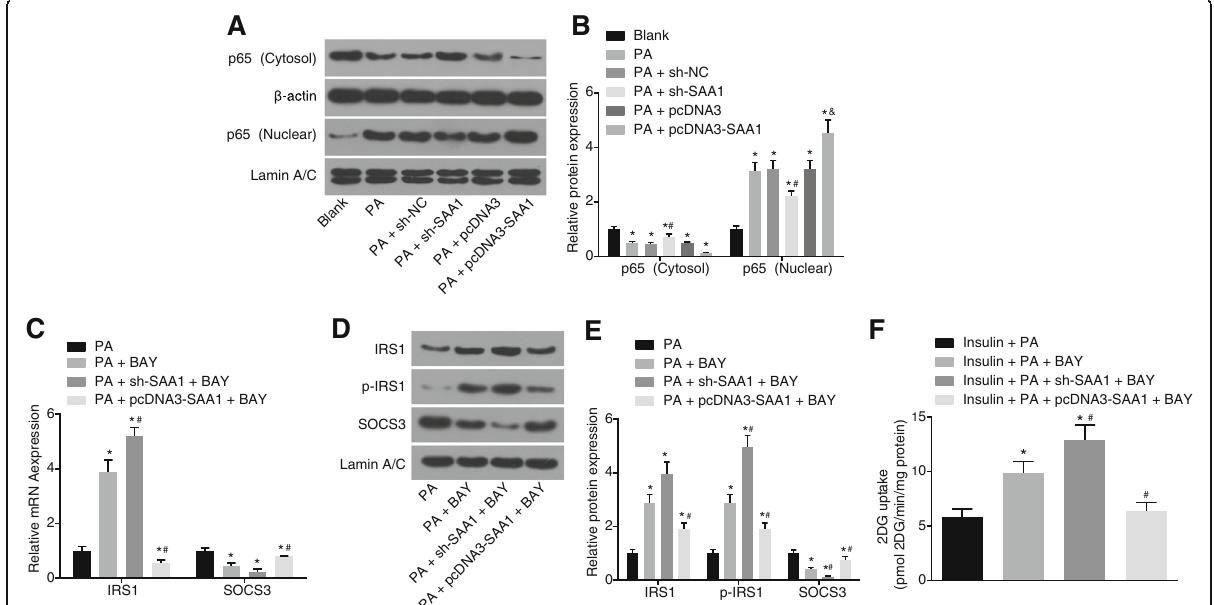
Fig. 3 Silencing of SAA1 exerts an inhibitory effect over PA-induced insulin resistance via the activation of the NF- κ B pathway. a , the gray value of cytoplasmic p65 and nucleus p65 protein bands according to the western blot analysis; b , the protein expression of cytoplasmic p65 and nucleus p65 in response to the treatment of PA+sh-SAA1, PA +pcDNA3, PA+pcDNA3-SAA1; *, p <0.05 vs. the blank group; #, p <0.05 vs. the PA+sh-NC group; &, p <0.05 vs. the PA+pcDNA3 group; c , the mRNA expression of IRS1 and SOCS3 in response to the treatment of PA+BAY, PA +sh-SAA1+ BAY, PA +pcDNA3-SAA1+BAY determined by RT-qPCR; *, p <0.05 vs. the PA group; #, p <0.05 vs. the PA +BAY group; d , the gray value of IRS1, p- IRS1 and SOCS3 protein bands in response to the treatment of PA+BAY, PA +sh-SAA1+BAY, PA+pcDNA3-SAA1+BAY according to the western blot analysis; e , the protein expression of IRS1 and SOCS3, and the extent of IRS1 phosphorylation in response to the treatment of PA+BAY, PA+sh- SAA1 + BAY, PA + pcDNA3-SAA1 + BAY according to western blot analysis; *, p < 0.05 vs. the PA group; #, p < 0.05 vs. the PA + BAY group; f , 2DG uptake in response to the treatment of insulin + PA+BAY, insulin + PA+sh-SAA1+BAY, insulin + PA+pcDNA3-SAA1+BAY; p <0.05 vs. the insulin + PA group; #, p <0.05 vs. the insulin + PA+BAY group; data were expressed by means ± standard deviation; multiple groups were compared by one-way analysis of variance; the experiment was repeated 3 times; SAA1, serum amyloid A protein 1; NF- κ B, nuclear factor- κ B; 2DG, [3H]2-Deoxyglucose Uptake; PA, palmitate; RT-qPCR, reverse transcription quantitative polymerase chain reaction; SOCS3, suppressor of cytokine signaling 3; IRS1, insulin receptor substrate 1; p-IRS1, phosphorylated IRS1; NC, negative